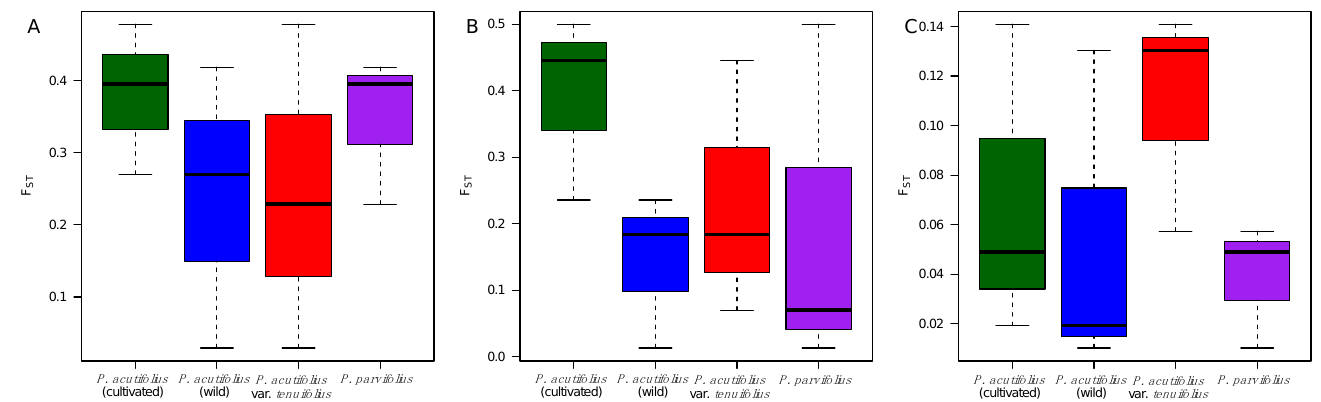
Figure 4. Boxplots of the pairwise F ST distributions at ( A ) Asr2 , ( B ) Dreb2B , and ( C ) ERECTA -encoding candidate genes for drought tolerance in tepary bean s.l. ( P. acutifolius – parvifolius clade). Boxplots colored by taxonomy: Green and blue for cultivated and wild P. acutifolius , red for P. acutifolius var. tenuifolius , and purple for P. parvifolius , the latter two wild.